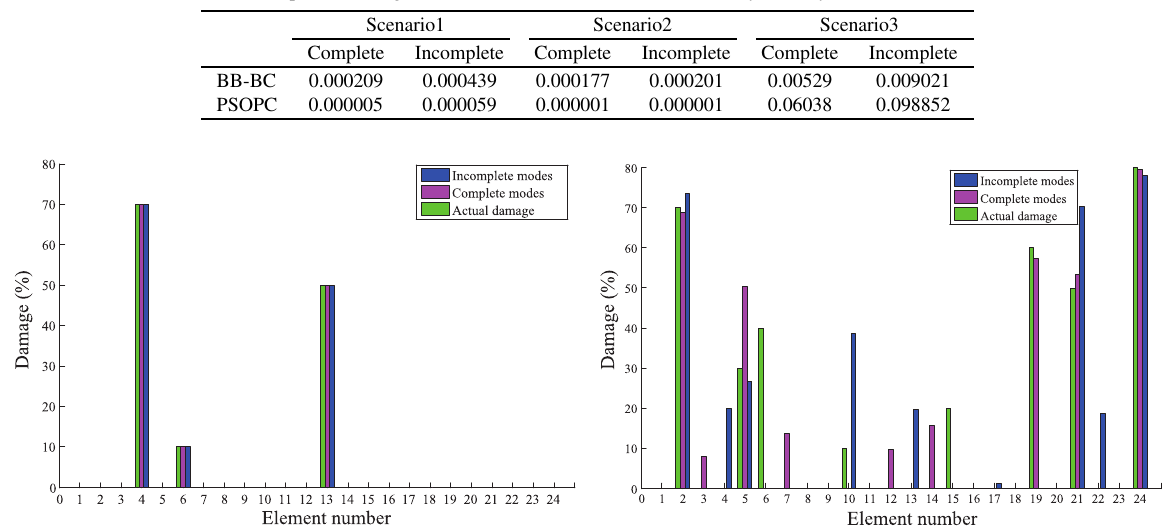
Fig. 15. Damage detection via PSOPC for three damage locations of frame (Scenario 2).